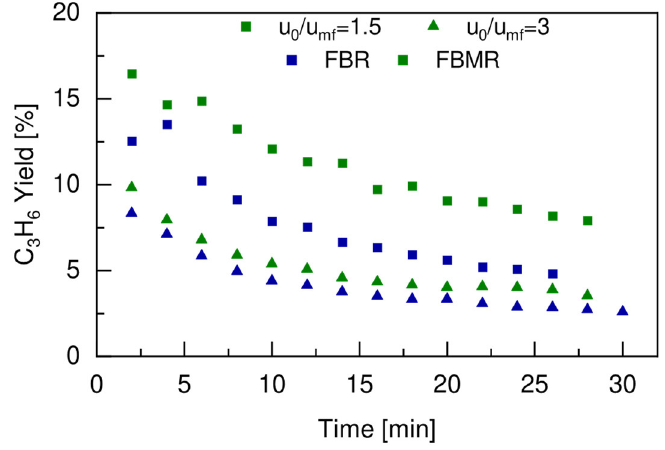
Figure 10. Propylene yield in the FBR (blue symbols) and FBMR (green symbols) working at 500 °C, 2 bar, with a feed composition of 30vol% C 3 H 8 -70 vol% N 2 , for u 0 /u mf = 1.5 ( ■ ) and u 0 /u mf = 3 ( ▲ ).